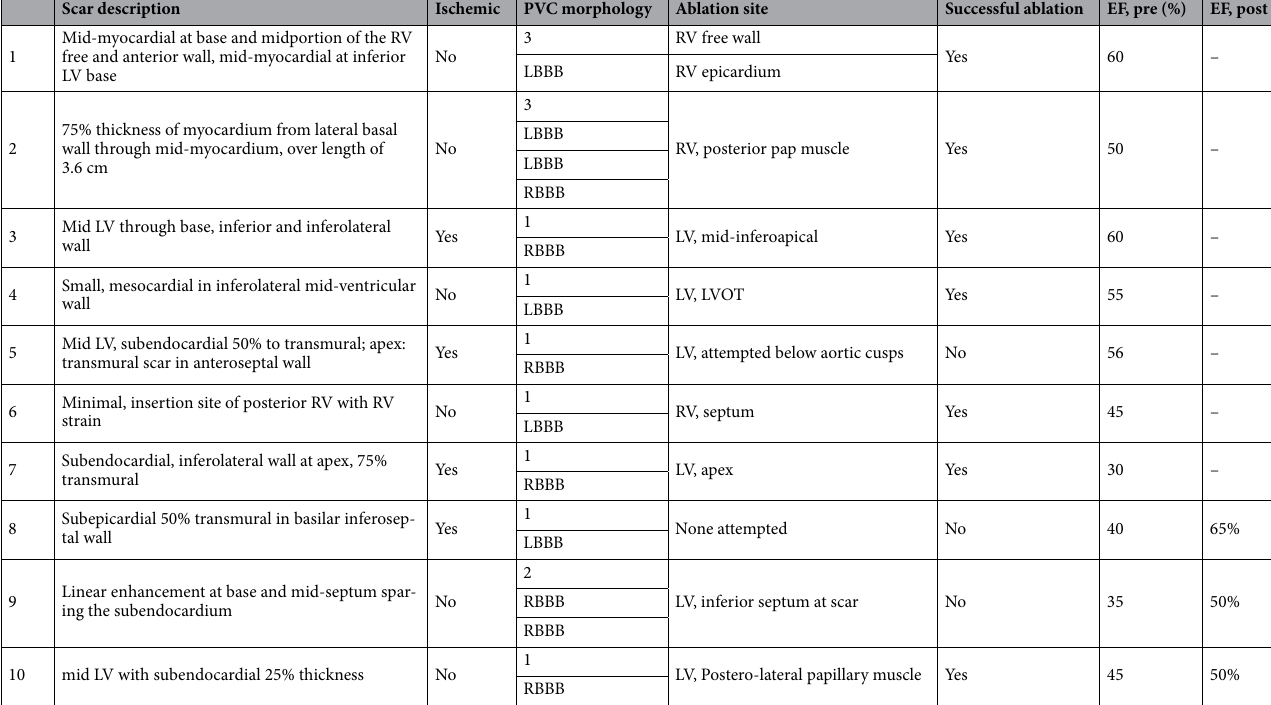
Table 4. Description of patients with scar noted on